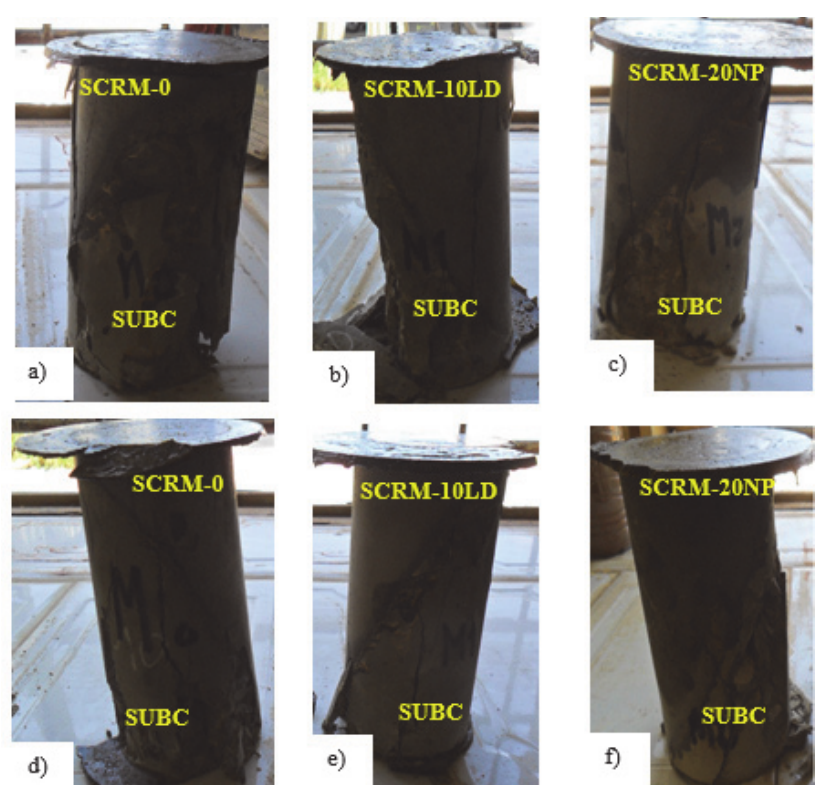
Table 4: Failure mode for composite samples in slant-shear test (a), (b) and (c) monolithic failure at 7-days, and (d), (e) and (f) substrate failure at